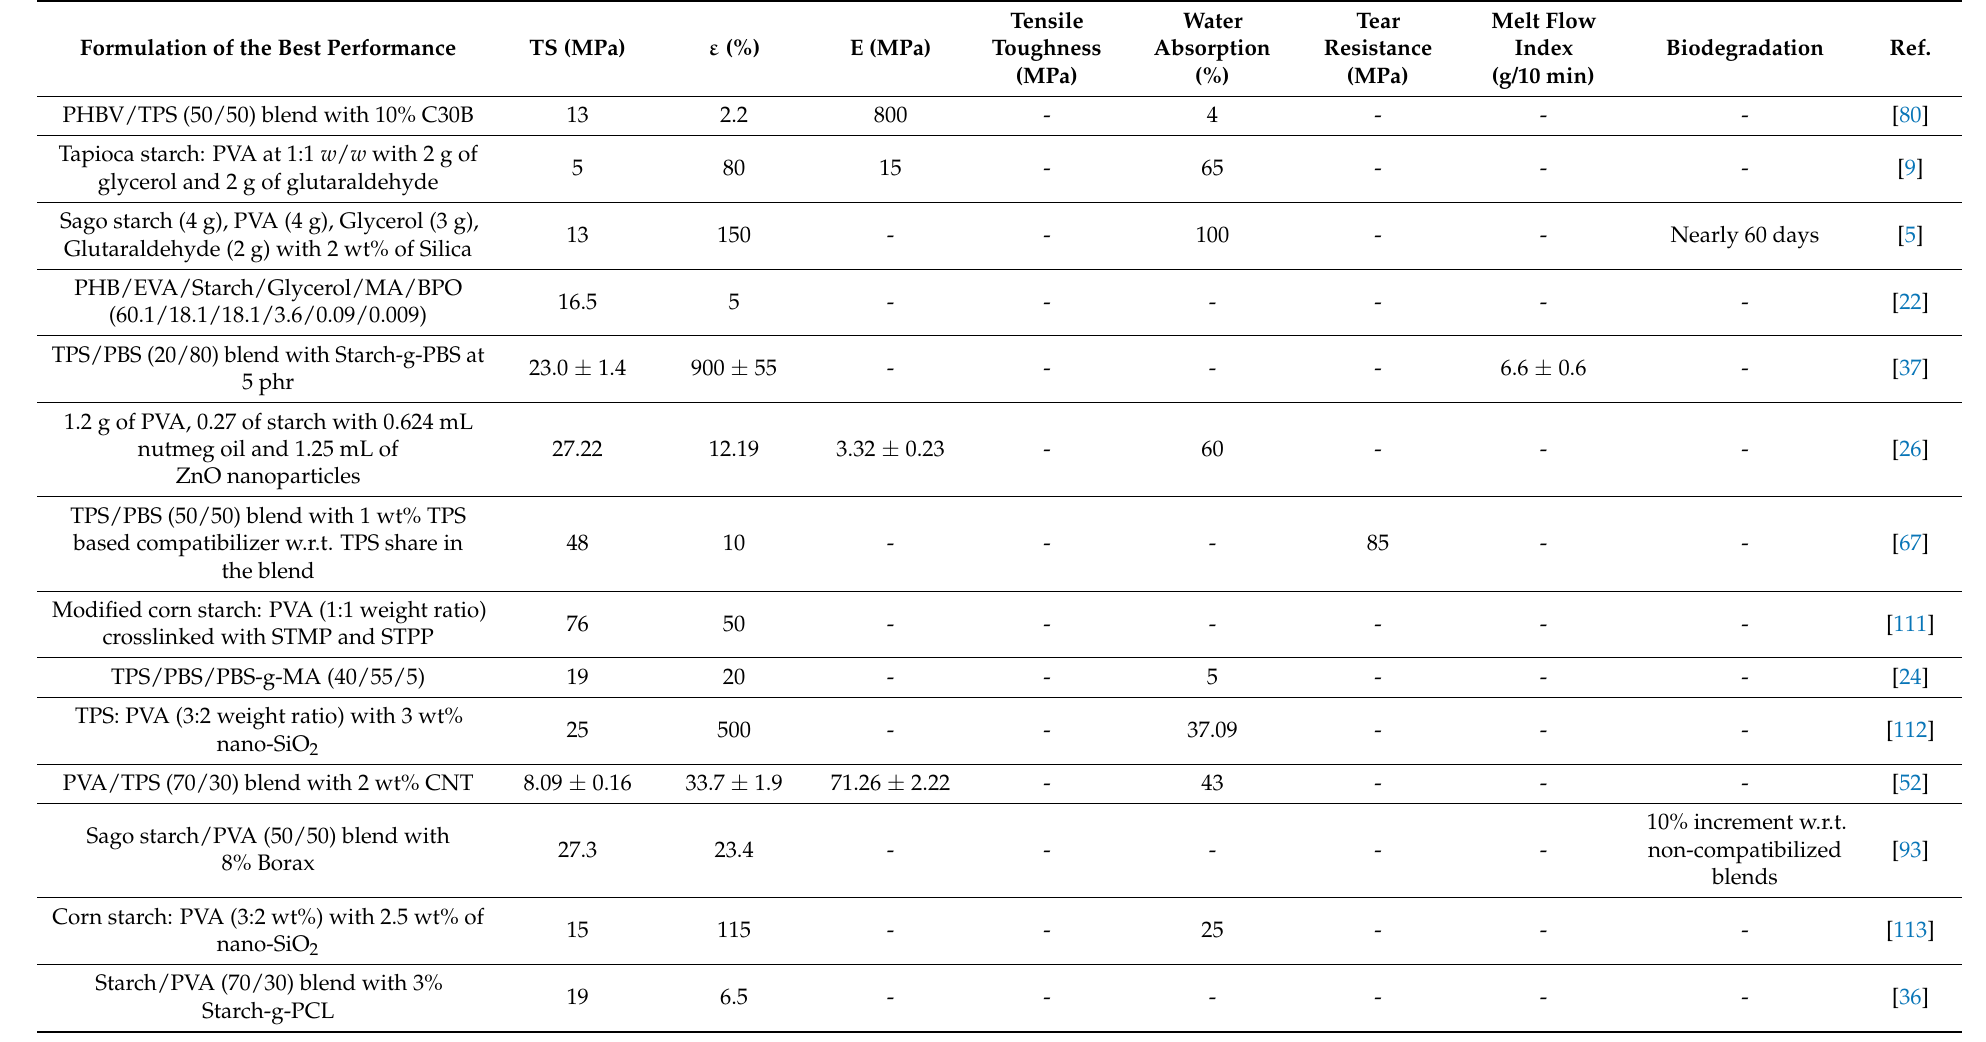
Table 9. Comparison of thermal, mechanical, water absorption and biodegradation properties of compatibilized Starch/Synthetic biodegradable polymer blends.